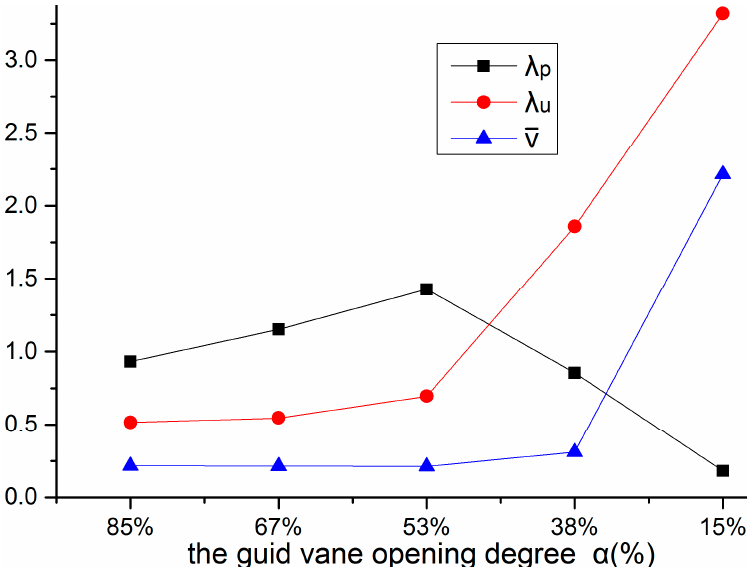
Figure 10. Non-uniformity indexes in different inlet attack angles.